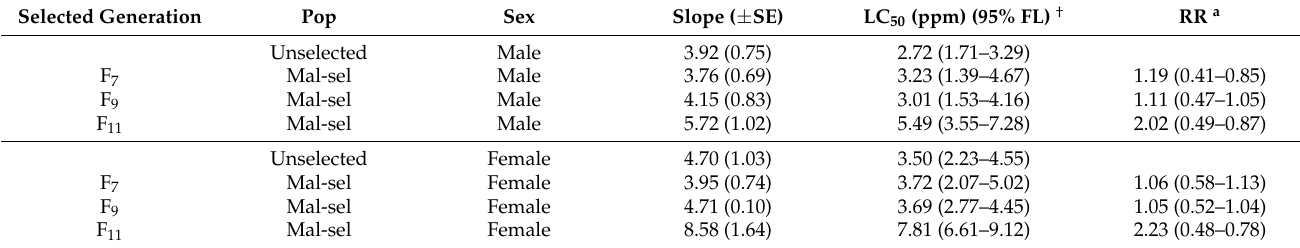
Table 2. Effect of malathion residue on adult male and female D. suzukii from malathion selected (Mal-sel) and unselected susceptible mixed field